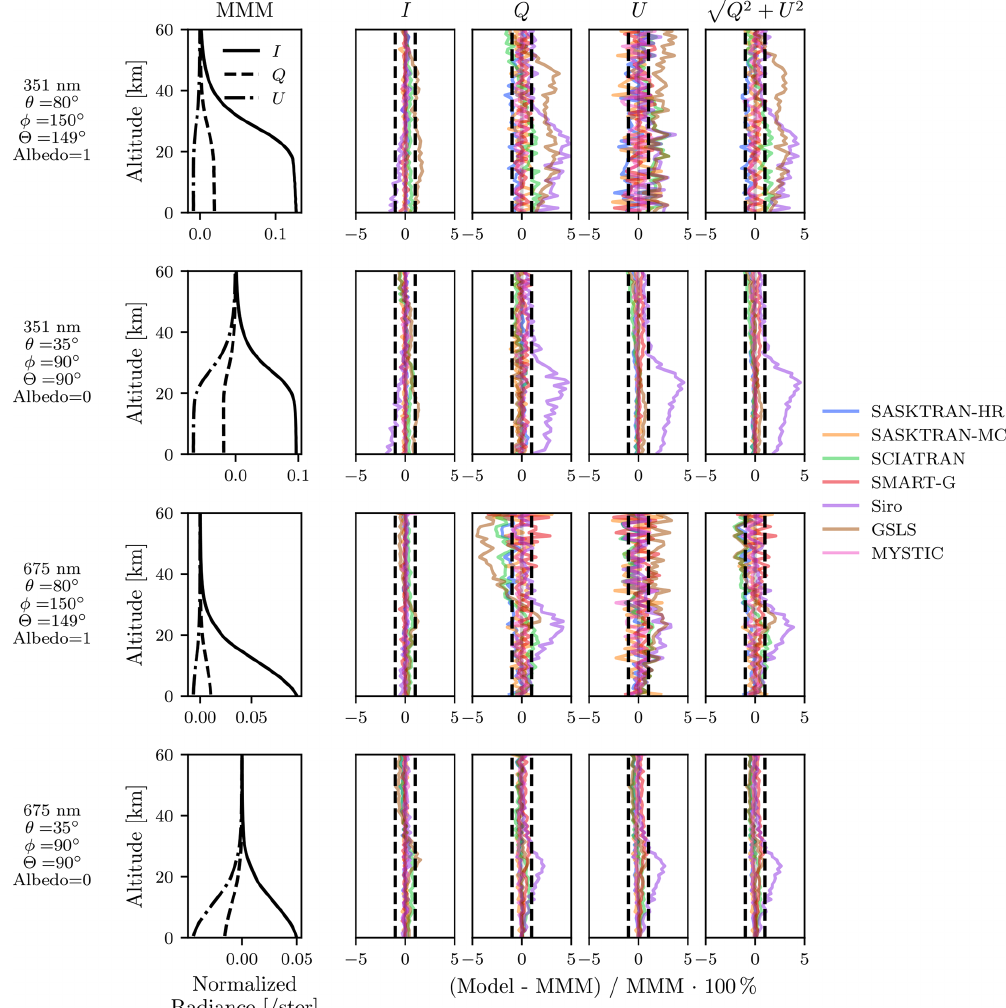
Figure 5. Leftmost column: the MMM calculation of I , Q , and U for four different scenarios consisting of MYSTIC, SASKTRAN-MC, and (cid:112) Q 2 + U 2 for each model relative to the MMM. The atmospheric optical SMART-G. Other columns: percent difference in I , Q , U , and properties include Rayleigh scattering, ozone absorption, and aerosol scattering. Dashed vertical lines indicate ± 1%